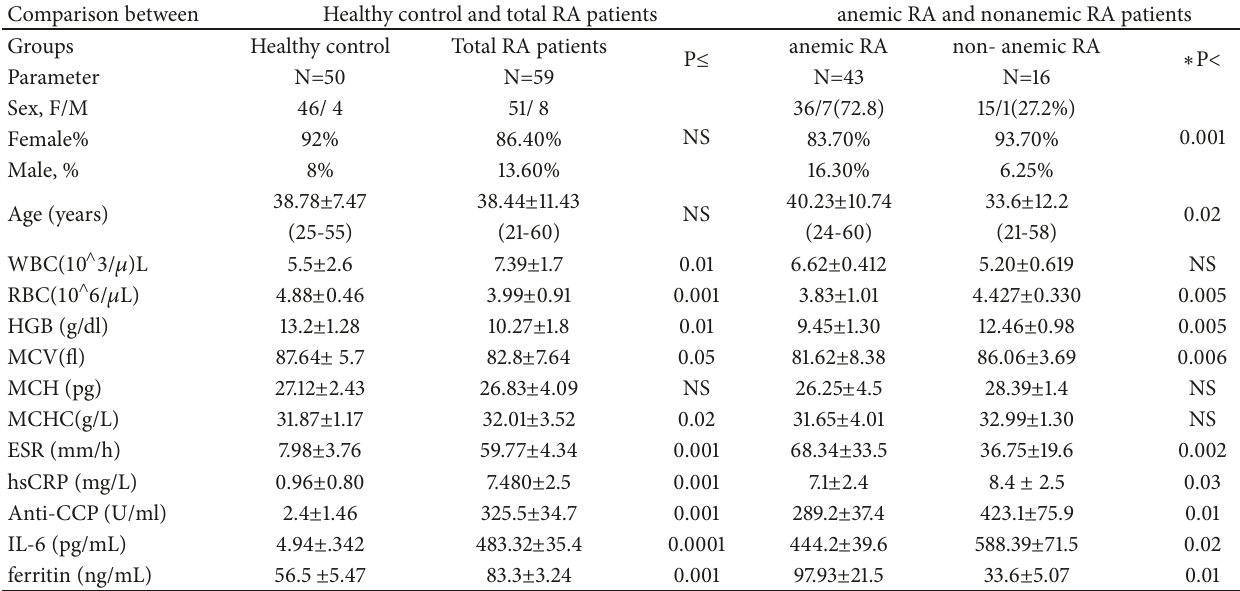
Table 1: Demographic, hematological, and immunological parameters comparison between healthy control and RA patients and between anemic and nonanemic RA